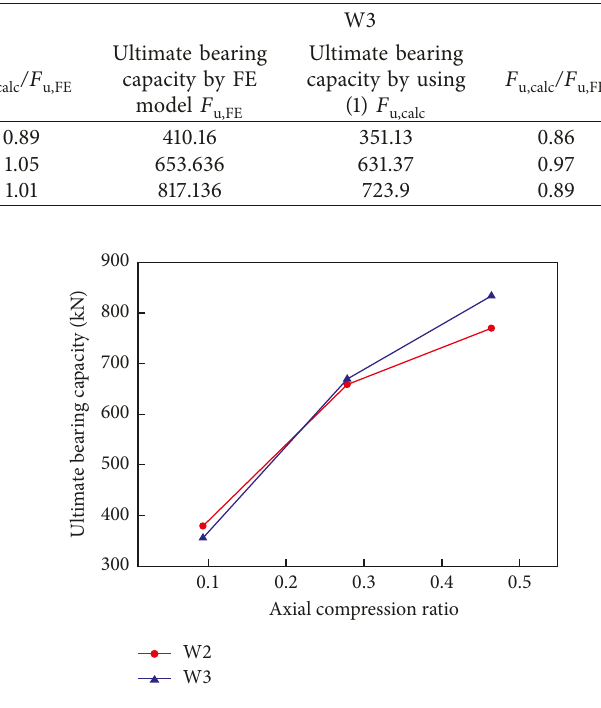
Figure 31: Variation of the simulated ultimate bearing capacity with axial compression